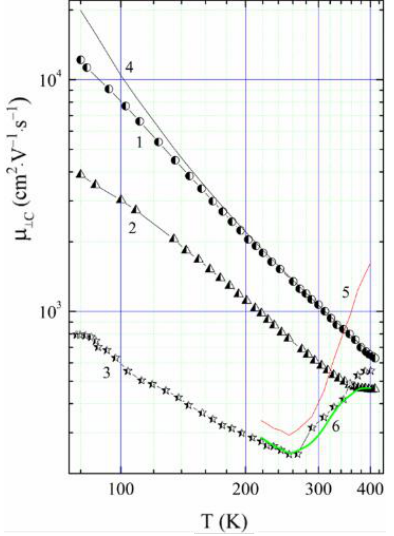
Figure 6. The in-plane mobility versus temperature for as-grown pristine (1), Co-intercalated (2), and Co-doped (3) n -type InSe crystals; calculated curves: 4 – μ FS ( Т ), 5 – μ SCR ( Т ) and 6 – total mobility. Table 2. In-plane electrical properties of various n -type InSe